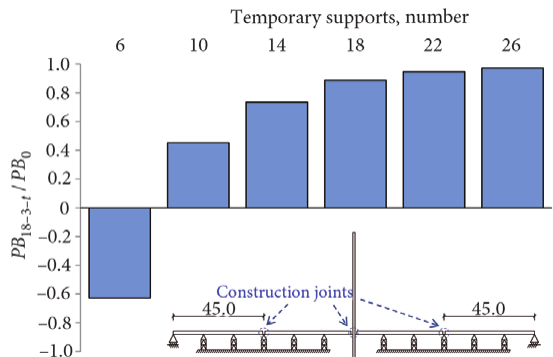
Fig. 9. Ratio between the bending moment at the deck-pylon connection of the bridge built with 3 construction joints and the target bending moment at that location for different number of temporary